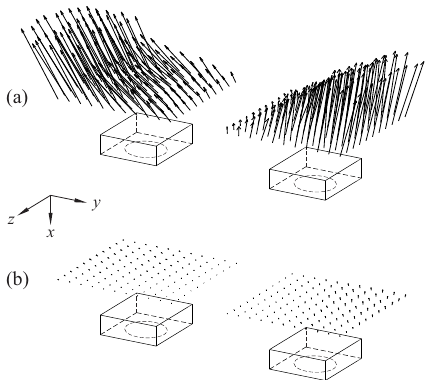
Figure 11: ⃗ I for h / λ = 0.18 . (a) primary, (b) residual on plane 2